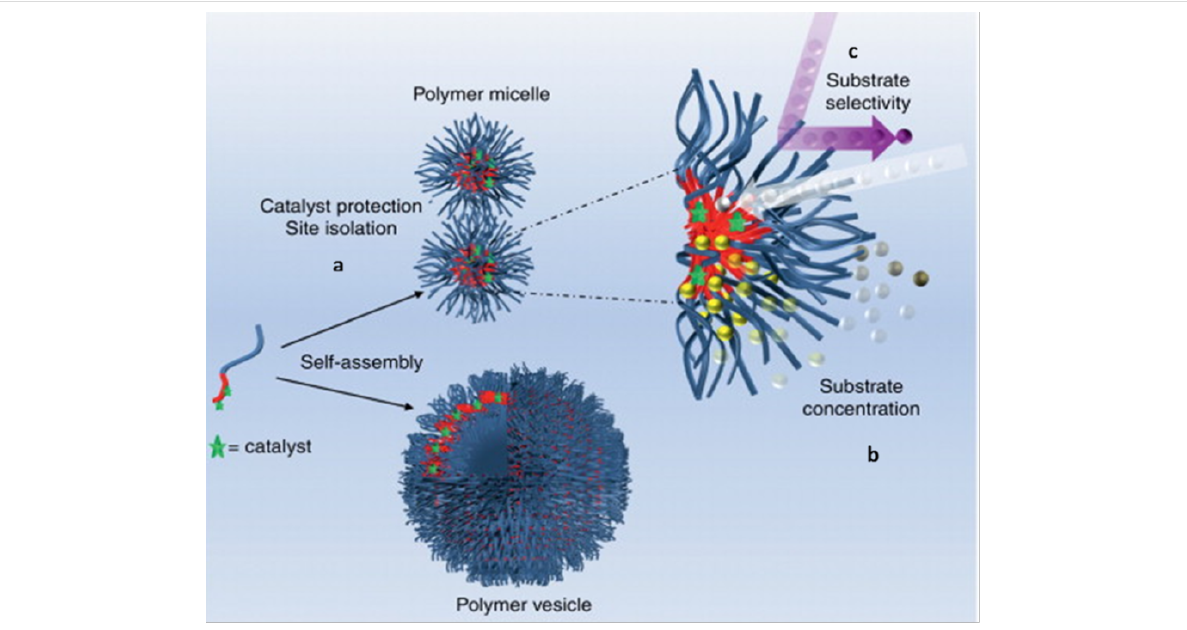
Figure 1: Assembly of catalyst-functionalized amphiphilic block copolymers into polymer micelles and vesicles. Characteristics of a nanoreactor system are shown using the polymer micelles including (a) the catalysts are protected and isolated from each other by the micellar shell, (b) substrates are effectively sequestered by the core from the surrounding environment, creating a highly concentrated environment for confined ca- talysis, (c) the nanostructure shell may regulate the access of substrates to the catalyst-containing micelle core. Reprinted with permission from refer- ence